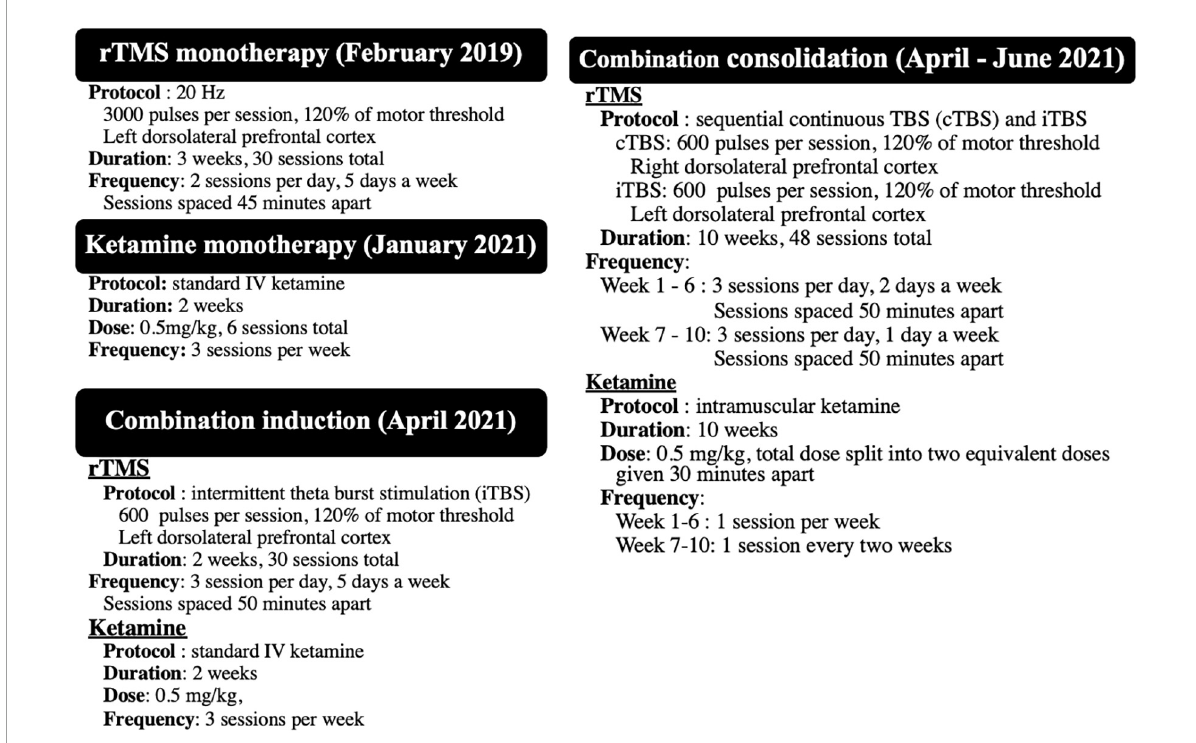
FIGURE1 Summary of the four different treatment protocols received between 2019 and